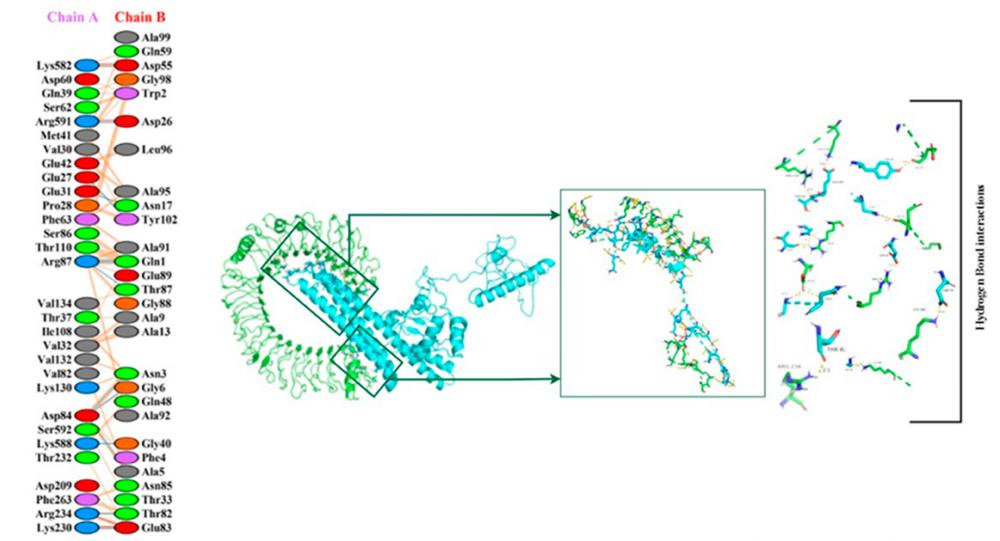
Figure 11. The figure shows the binding interaction between the active residues of the docked complex of human TLR-4 and the vaccine construct. Chain A represents active residues of TLR-4, while chain B represents active residues of the vaccine